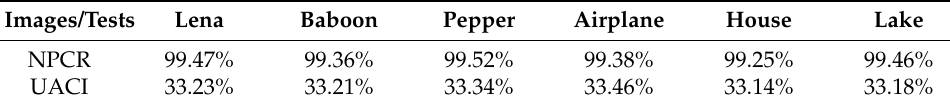
Table 9. NPCR and UACI results.